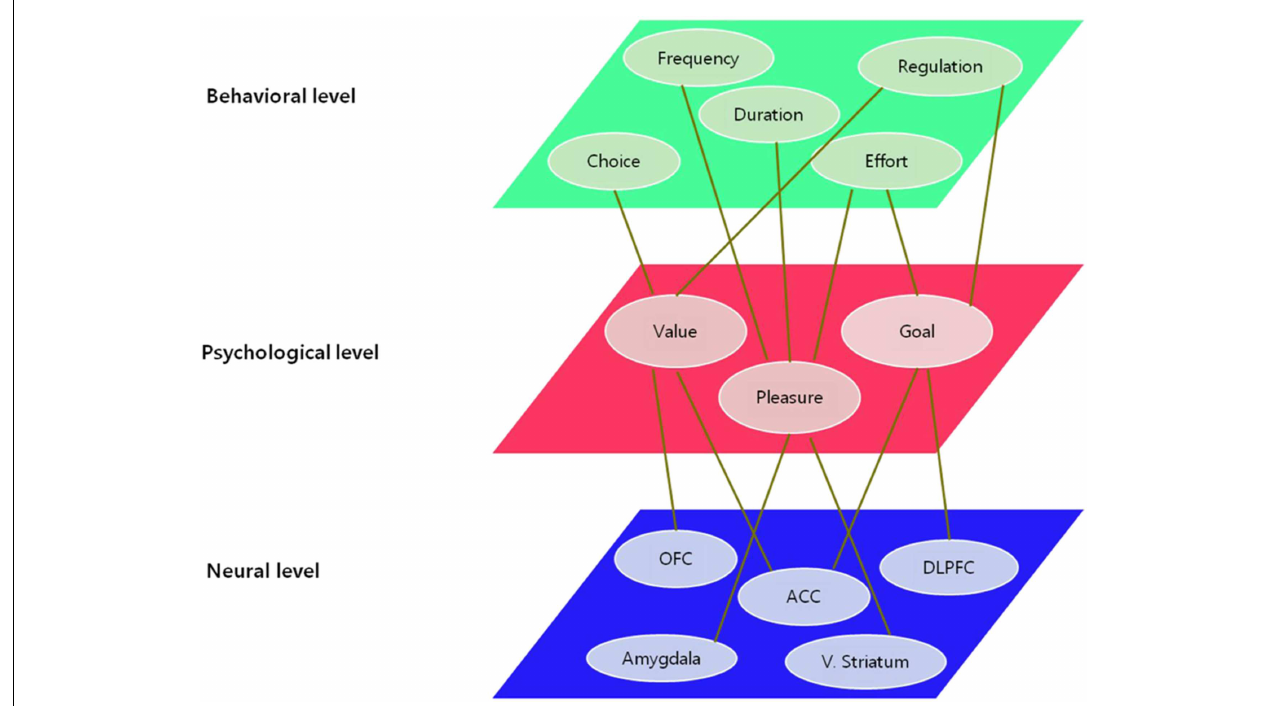
FIGURE 1 | Levels of explanation and units of analysis on